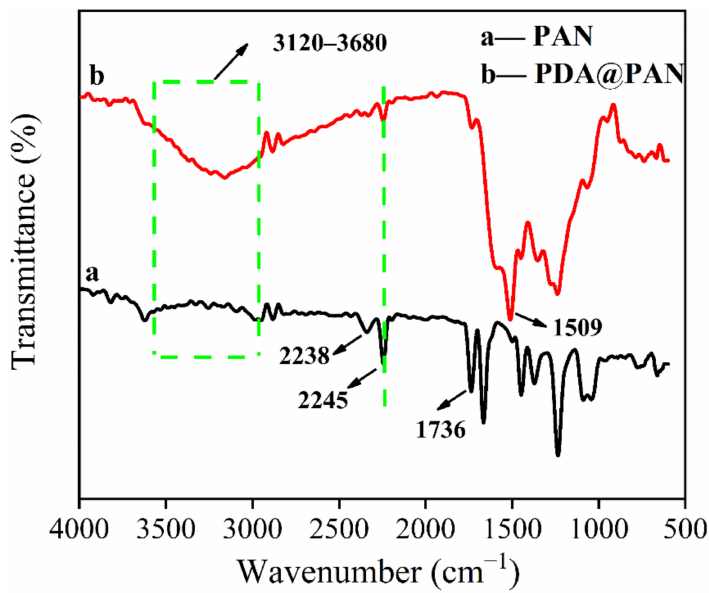
Figure 4. FTIR spectra of PAN (a) and PDA@PAN (b) nanofibrous membrane. The chemical environment of the surface atoms of the fibrous membrane was further analyzed by XPS to determine the successful coating of PDA. Figure 5a shows the XPS full spectra of PAN and PDA@PAN nanofiber membranes, and the inset is a table of relative atomic percentage. It can be observed from Figure 5a that the two membrane samples have XPS peaks of C 1s, N 1s and O 1s emerging at electron binding energies of 284.9, 399.1 and 531.5 eV, respectively [46]. From the inserted relative atomic percentage table, it can be found that content of O 1s increased from 3.66% to 22.46% after PDA modification, which is consistent with previous EDX and FTIR analysis results. At the same time, it is observed that the ratio of O/C atomic content is also significantly increased compared PDA@PAN to that of the PAN nanofirous membrane, which is also a result of the modification of PAN nanofibers by